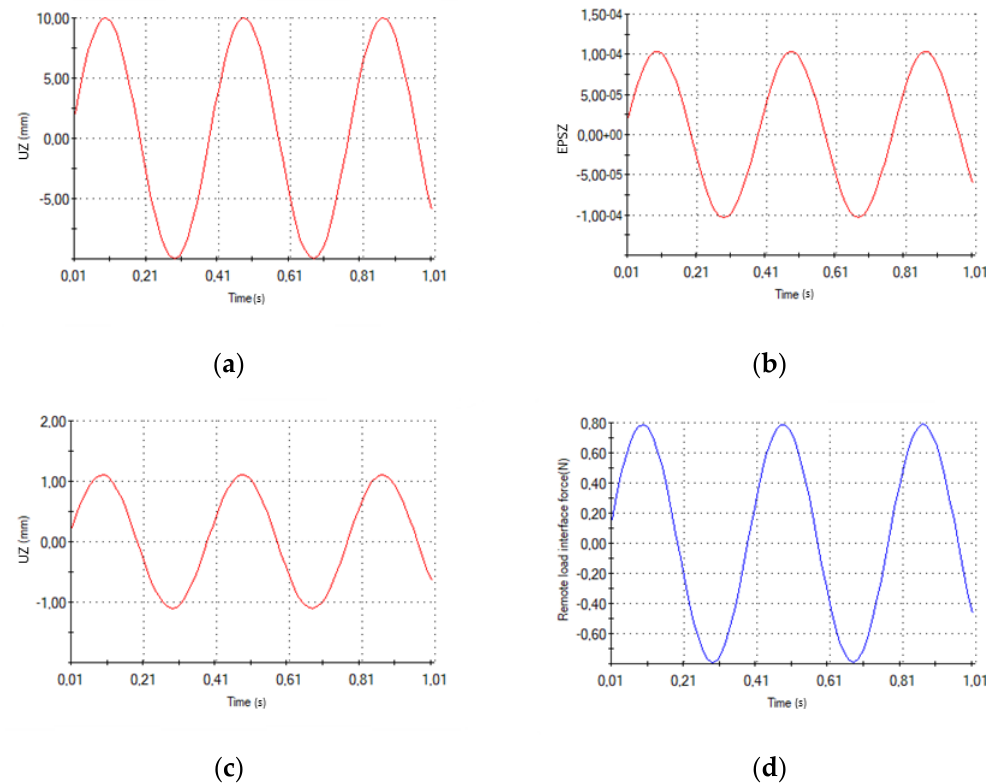
Figure 9. FEA screens from Solidworks: ( a ) imposed displacements at the free end over time, ( b ) Z-normal nodal averaged strain on upper PPT surface over time, ( c ) displacements along Z-axis at 100 mm from fixed joint cross-section over time, and ( d ) nodal averaged reaction force along Z-axis at 100 mm from fixed joint cross-section.